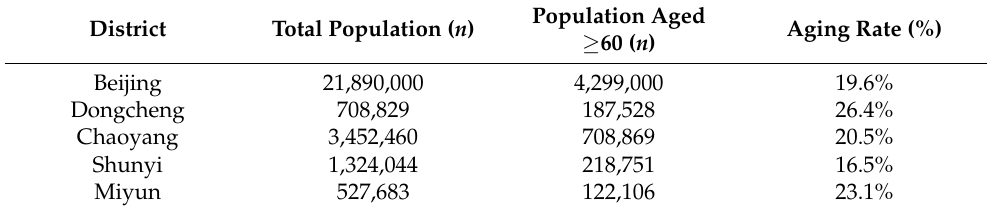
Table 1. Population size and aging rate (2020) in four Beijing districts chosen as study areas. District Total Population ( n